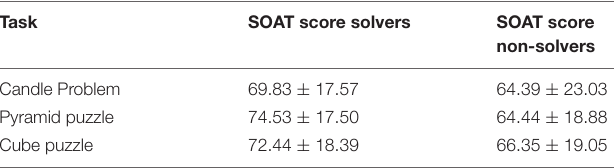
TABLE 3 | SOAT score for solvers and non-solvers in Tasks III and IV.